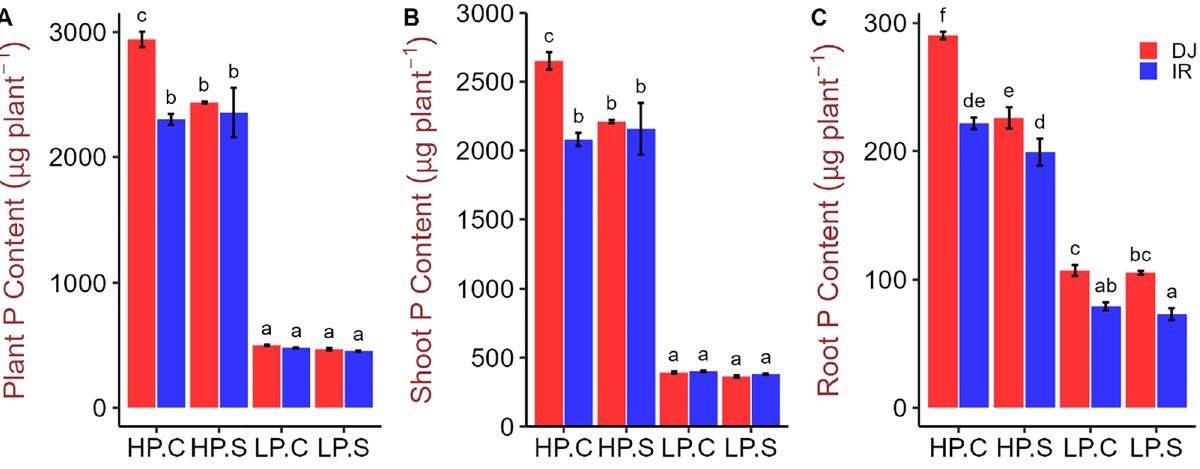
Figure 4. Phosphorus content in whole plant, shoot and root of DJ123 and IR64 grown under varying phosphorus supply. Data are the mean ± SE of four independent replicates. ‘HP’ and ‘LP’ stand for high- and low-phosphorus supply, respectively. Plants were grown on HP and LP treatments for 40 days after germination. Then, both groups were splitted into two sub-groups. Phosphorus supply was continued as usual for one sub- group of each treatment (labelled as ‘C’) and stopped for the other group (labelled as ‘S’). After approximately 24 and 48 h, LP and HP sub-groups were harvested, respectively. Significant differences among treatments were determined by ‘generalised least square’ model, separated by Tukey’s test (P < 0.05), and are indicated by different letters.